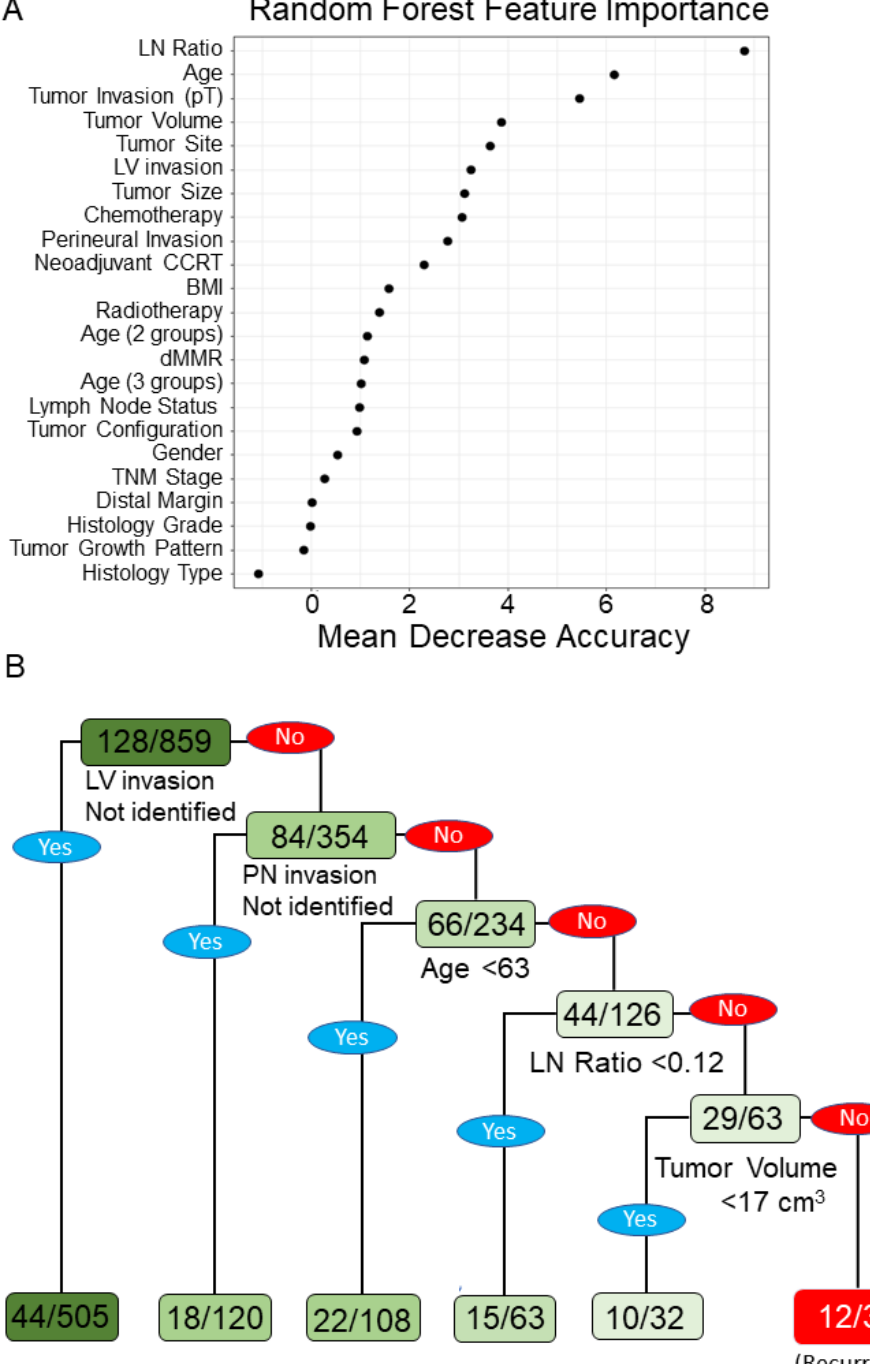
Figure 2. Prognostic factors in the random forest (RF) model and CART decision tree analysis. ( A ) The importance of factors in terms of the mean decrease in accuracy in the RF model. We ranked the relative importance for all these prognostic factors. From the results, the top five factors that corresponded to cancer recurrence were the lymph node ratio, age, depth of tumor invasion stage (pT), tumor volume, and tumor site. ( B ) A decision tree was generated by the CART model to optimize the risk stratification in cancer recurrence. The internal nodes of the tree represent prognostic factors, including lymphovascular (LV) invasion, perineual (PN) invasion, age, lymph node ratio, and tumor volume.